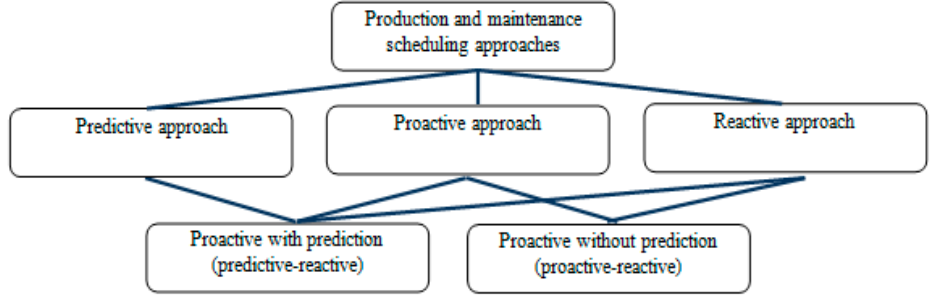
Figure 1. Classification of production and maintenance scheduling approaches.